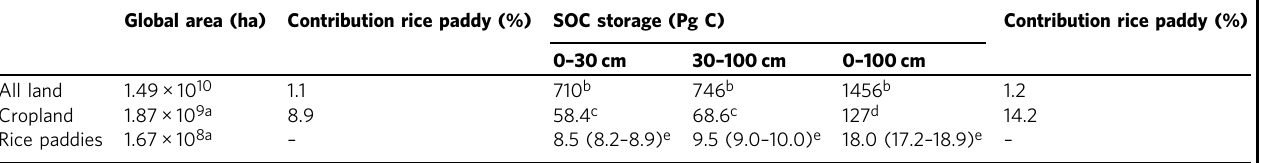
Table 2 Estimates of global land area, global cropland area, global paddy area, and soil organic carbon (SOC) storage. Global area (ha) Contribution rice paddy (%) SOC storage (Pg C)